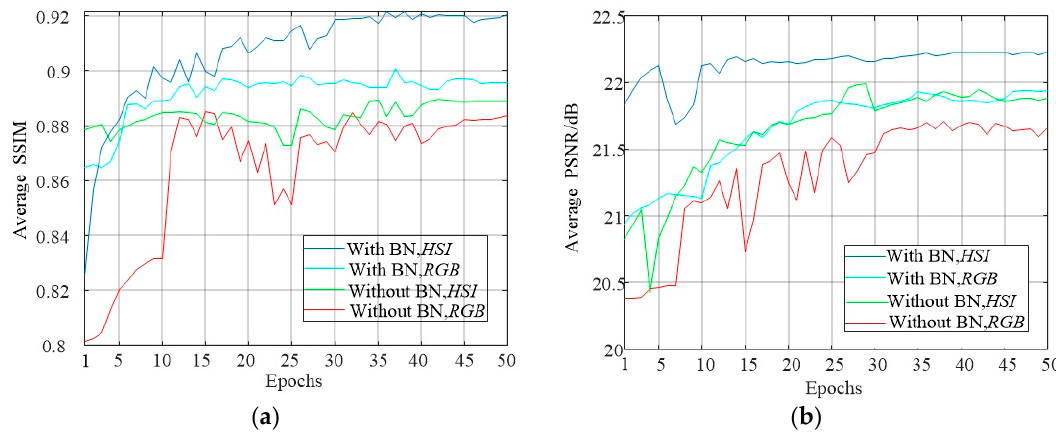
Figure 10. The convergence performance for SSIM and PSNR of HSI and RGB methods under BN and